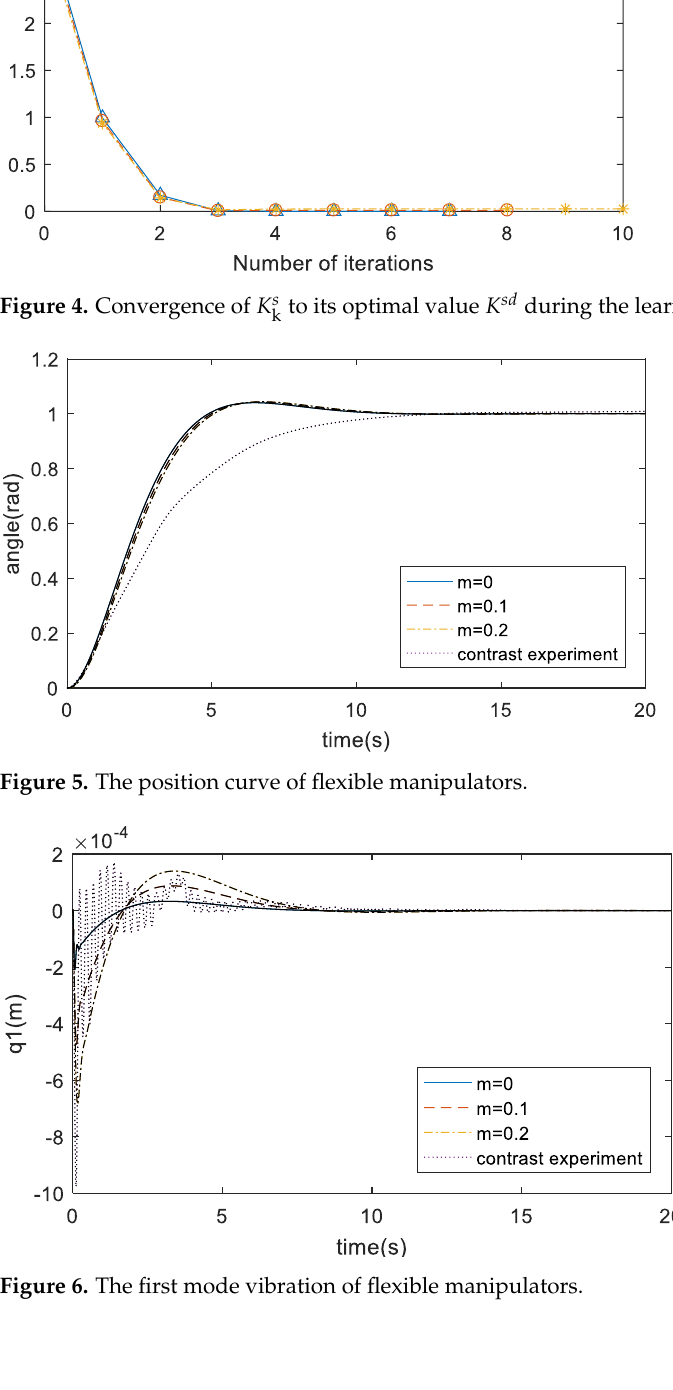
Figure 6. The first mode vibration of flexible